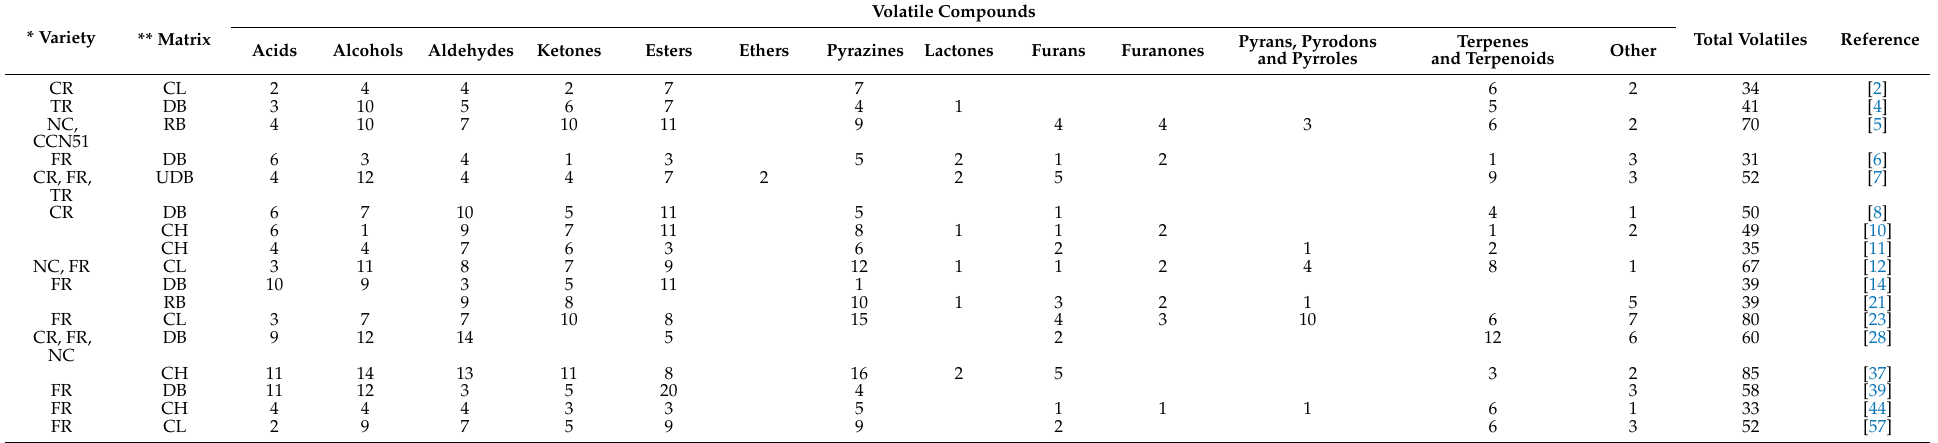
Table 2. Number of common volatile compounds in the cocoa bean processing